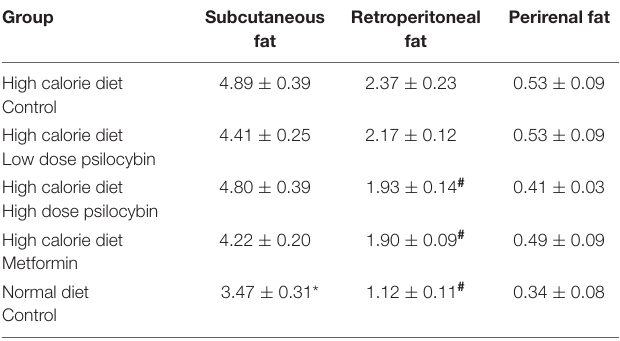
TABLE 2 | Relative adiposity for different fat pads following 27 days of